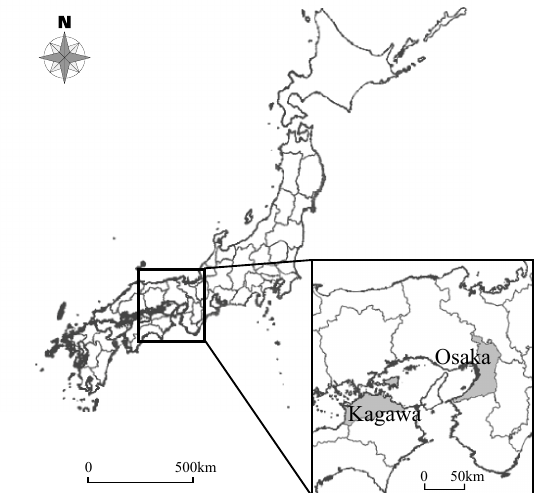
Figure 1 . Study areas and their locations. The grey areas in the enlarged view of the map show Osaka and Kagawa